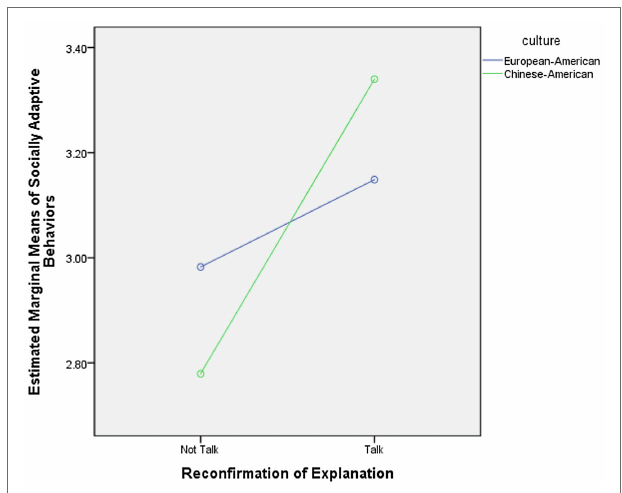
FIGURE 2 | Culture by mothers’ reconfirmation of explanation interaction effects on children’s socially adaptive behaviors. ** p <